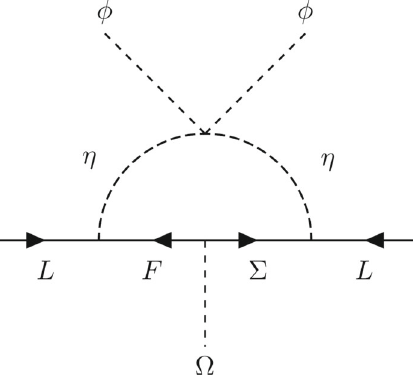
Fig. 1 “Scotogenic” neutrino masses. After electroweak symmetry breaking the SM-like Higgs acquires a VEV (cid:7) φ 0